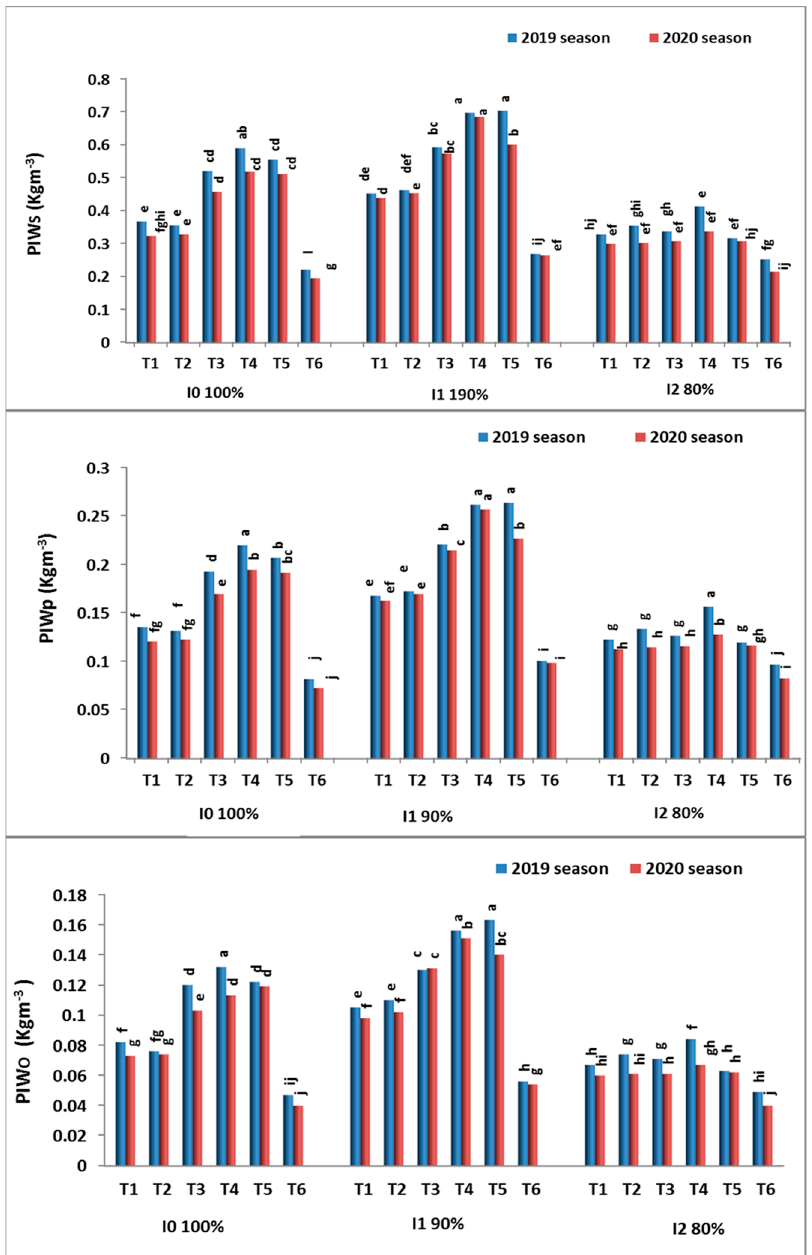
Figure 6. Effect of interactions between irrigation levels and weed control treatments on productivity of irrigation water PIWs, PIWo, and PIWp in the 2019 and 2020 seasons. I 0 : 100% irrigation level T 1 : pendimethalin CS 45.5% T 4 : imazethapyr WG 60%; I 1 : 90% irrigation level T 2 : oxyfluorfen EC 24% T 5 : hand-hoeing twice; I 2 : 80% irrigation level T 3 : bentazon AS 48% + clethodim EC 12.5% T 6 : untreated check; PIWs: productivity of irrigation water based on seed yield; PIWo: productivity of irrigation water based on oil yield; PIWp: productivity of irrigation water based on protein yield. Different letters represent significant differences (0.05).